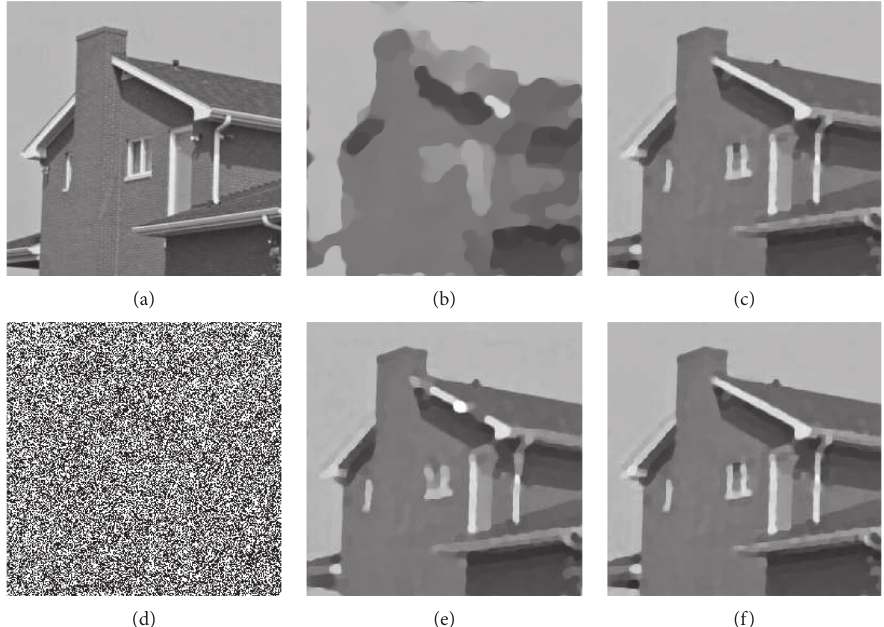
Figure 5: The recovery results (House 256) by Gaussian blur with 90% SP noise. (a) Original. (b) TVL1, PSNR � 19.0225. (c) TVSCAD, PSNR � 27.0674. (d) Gaussian blur (lev � 0.9). (e) TVLog, PSNR � 24.362. (f) LogTVSCAD, PSNR �